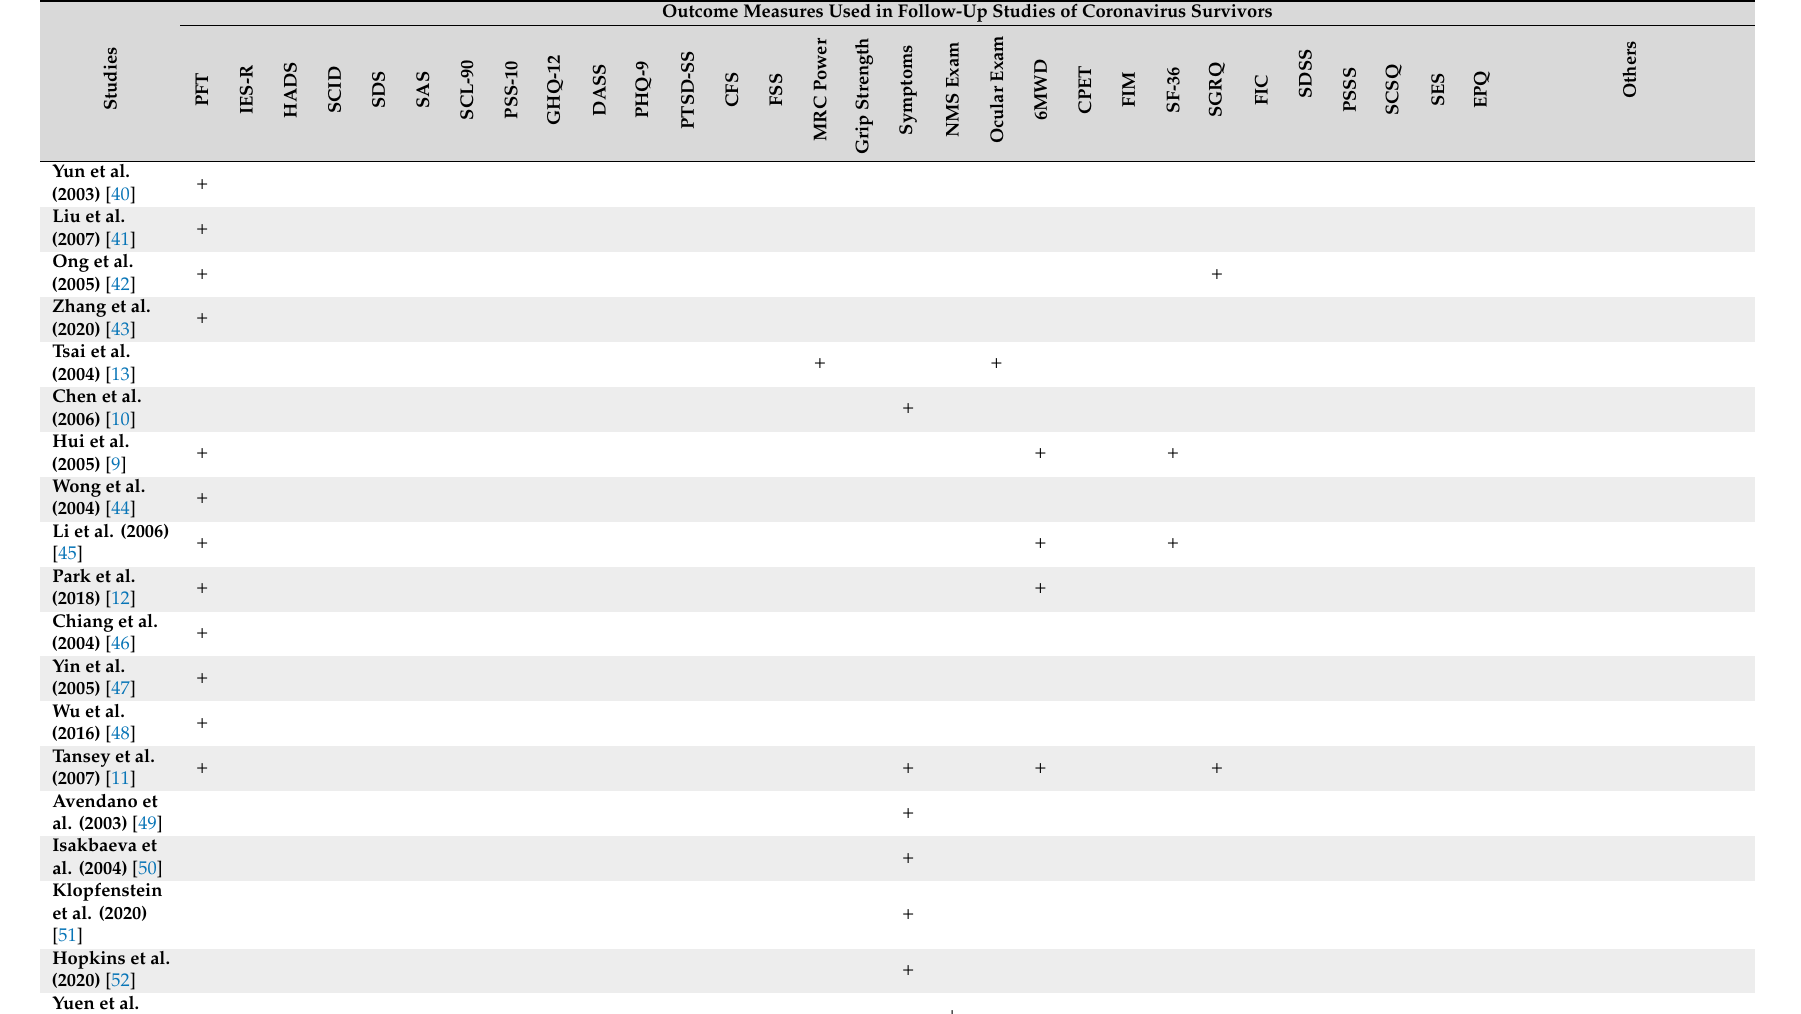
Outcome Measures Used in Follow-Up Studies of Coronavirus